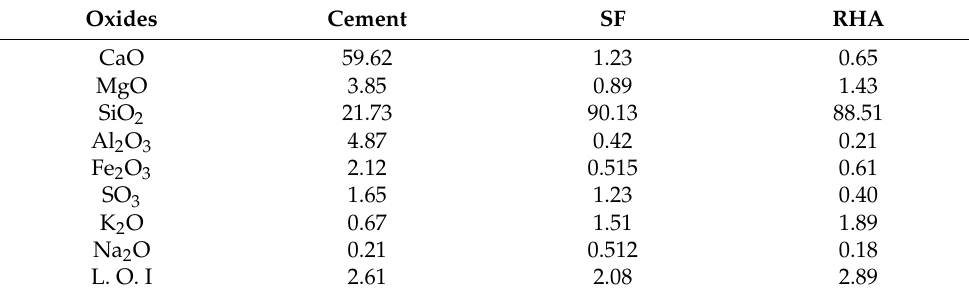
Table 2. Chemical composition of cement, SF, and